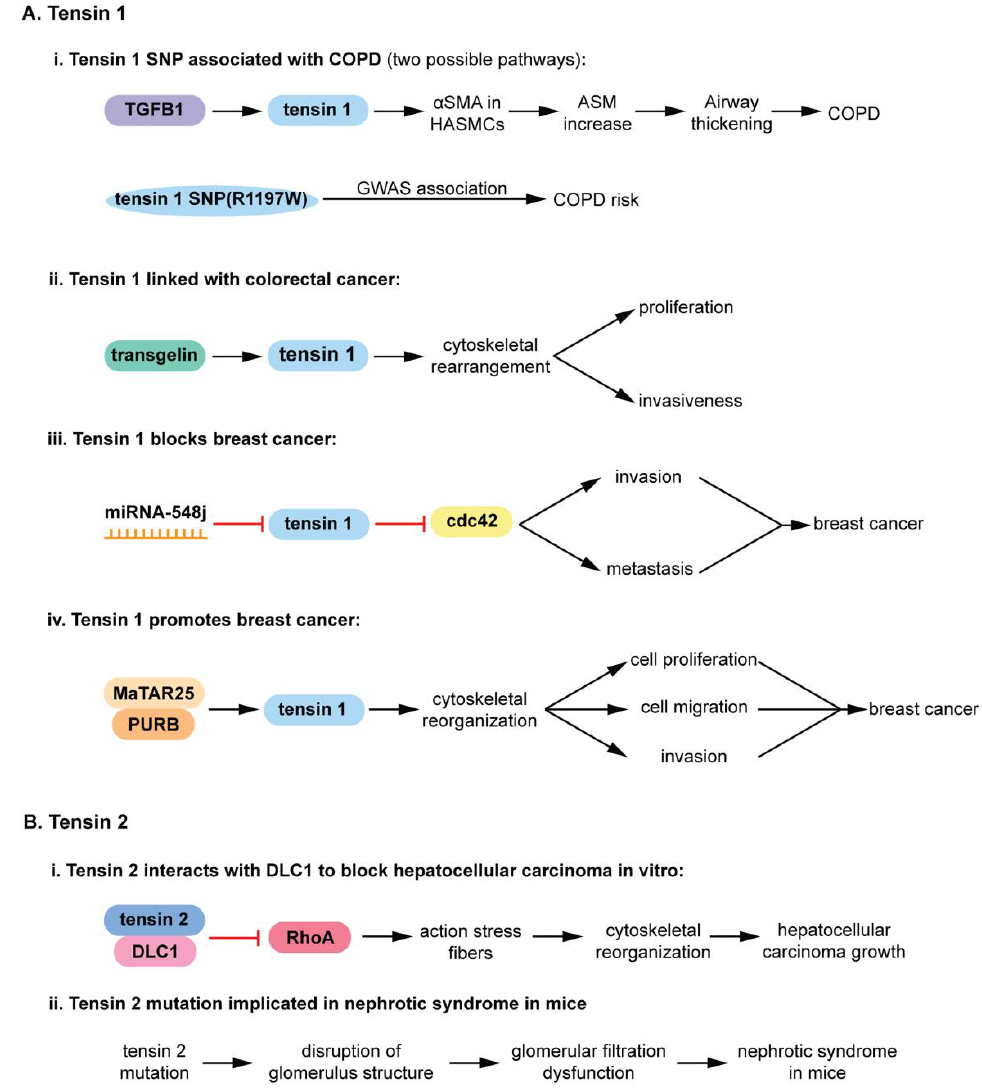
Figure 4. Roles of tensin family members in disease: ( A ) Tensin 1 roles in disease. ( i ) Tensin 1 SNP is linked to chronic obstructive pulmonary disease (COPD) thorough experimental evidence and GWAS. TGF β 1 upregulates tensin 1 (R1197W) expression, increasing downstream effectors leading to airway thickening that is characteristic of COPD. ( ii ) Tensin 1 is linked with human colorectal cancer through transgelin signaling, upregulating metastatic and proliferative signaling of colorectal cancer cells. ( iii ) Tensin 1. Tensin 1 translation is prevented by miRNA-548j, resulting in hyperactivation of cdc42 that increases invasion and metastasis in breast cancer. ( iv ) Tensin 1 promotes breast cancer. The MaTAR25 lncRNA interacts with PURB to increase tensin 1 mRNA and protein levels, resulting in cytoskeletal rearrangements that augment proliferation, migration, and invasion in breast cancer cells. ( B ) Tensin 2 roles in disease. ( i ) Tensin 2-DLC1 (deleted in liver cancer 1) complex inhibits RhoA. This prevents RhoA-mediated actin stress fiber generation, which in turn prevents cytoskeletal rearrangements that support hepatocellular carcinoma growth. ( ii ) Tensin 2 mutation implicated in nephrotic syndrome in mice. An 8-nucleotide deletion in tensin 2 triggers a frame shift that introduces a nonsense mutation. This mutant gene is associated with lower tensin 2 mRNA and protein levels in mouse kidneys. These tensin 2 deficient mice present with disruption of glomerulus structure and glomerular filtration dysfunction, suggesting that tensin 2 deficiency leads to nephrotic syndrome in an animal disease model.